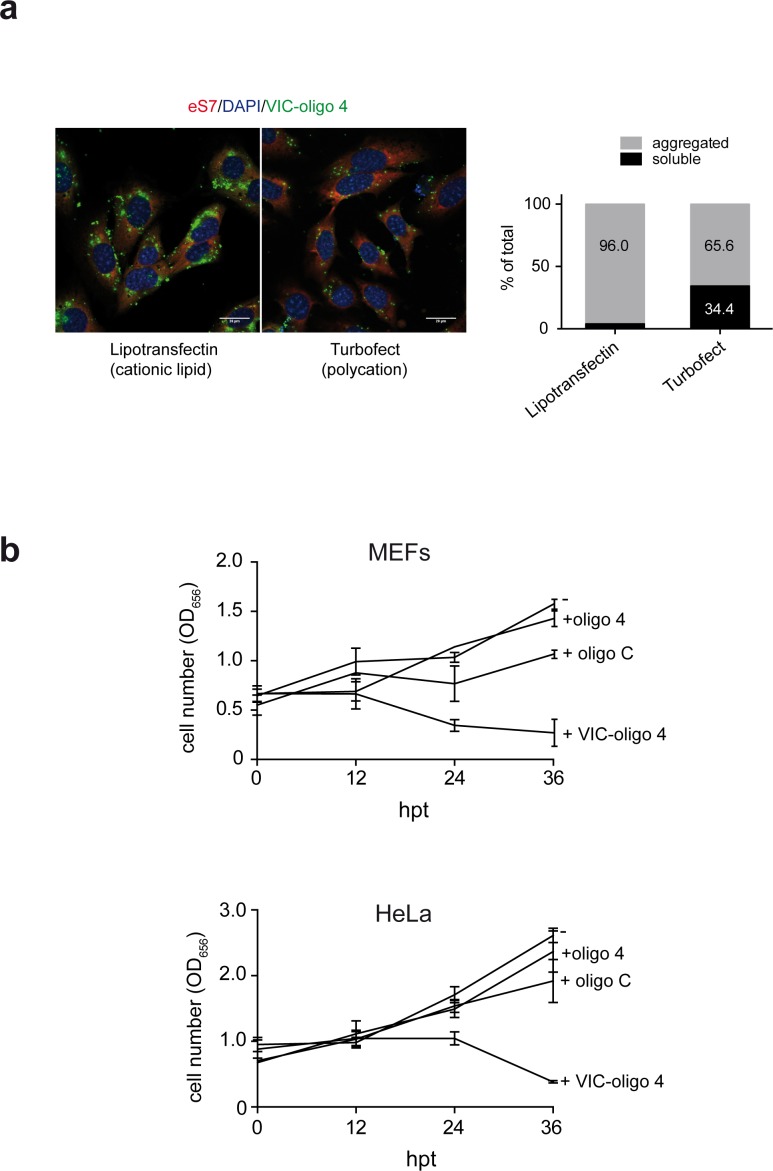
Accumulation of VIC-oligo 4 into the cells and its effect on proliferation.(a) Comparative analysis of the effects of lipotransfectin and turbofect transfection reagents on intracellular accumulation of VIC–oligo 4. MEFs were transfected and fixed 12 hr later for immunofluorescence analysis (left), as in Figure 3. Parallel transfections were lysed in polysome buffer and postnuclear fractions were centrifuged at 10,000 rpm in a minifuge for 30 min to separate soluble from aggregated VIC–oligo 4. The relative amount of VIC-oligo 4 in each fraction was quantified by fluorescence and expressed as % of total. Note that the right micrograph corresponds to the one shown in Figure 3. (b) Effect of VIC–oligo 4 on the proliferation of MEFs and HeLa cells. At the indicated times post-transfection, cells were fixed with formaldehyde and stained with crystal violet. Then, monolayers were solubilized in 10% acetic acid and the corresponding absorbance at 656 nm was measured. Data are the mean ± SD of three independent experiments.